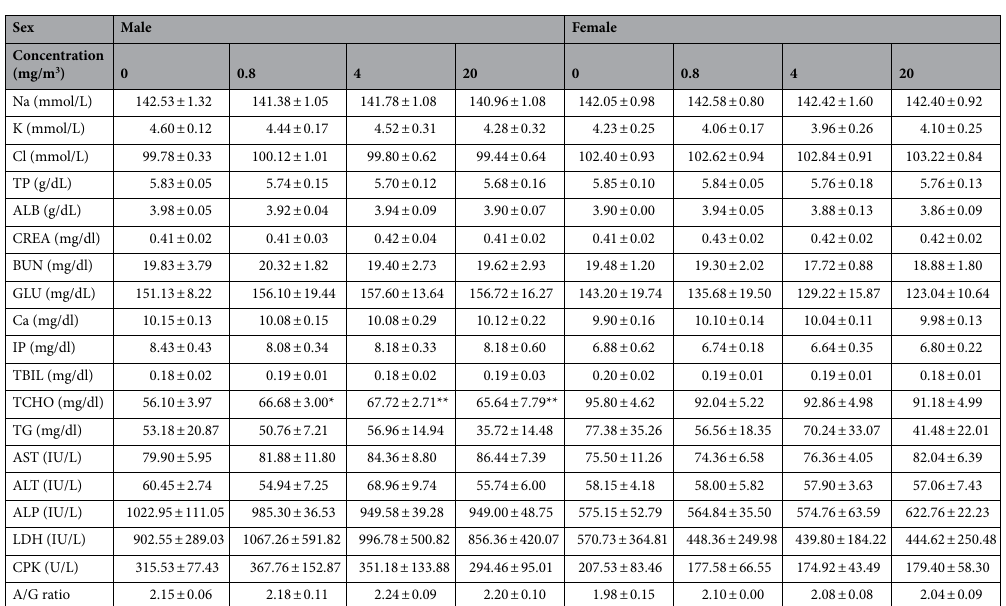
Table 2. Blood chemical parameters of main group male rats exposed to NaDCC. The values are expressed as mean ± SD (n = 5 males per group), *Dunnett Test Significant at the 0.05 level; **Dunnett Test Significant at the 0.01